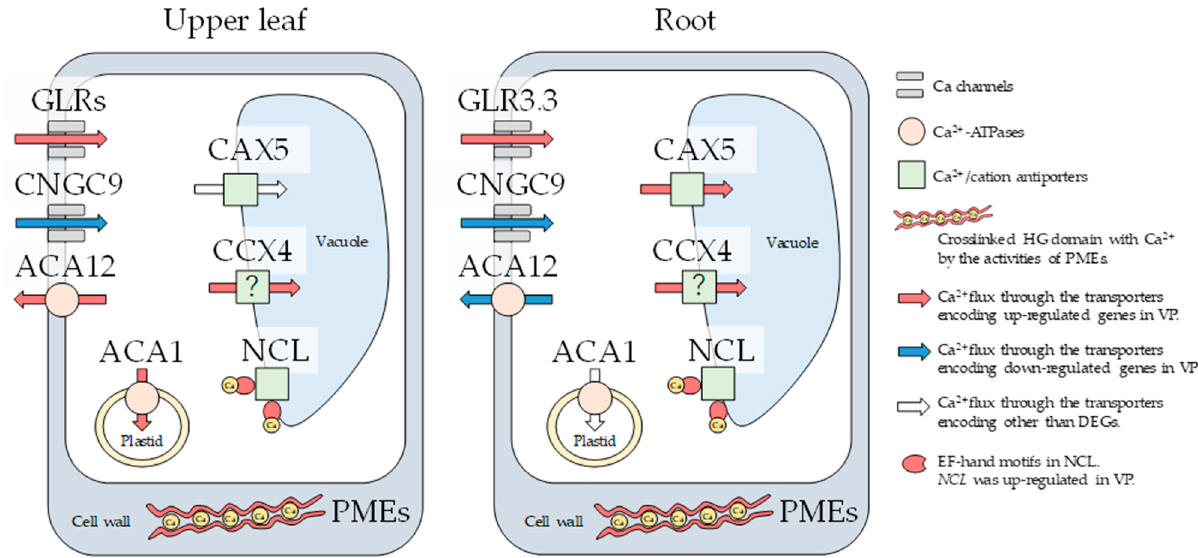
Figure 2. Hypothetical diagram of cellular Ca dynamics in upper leaves and roots of tipburn high damaged cultivar (VP). Direction of arrows indicates Ca flux through the transporters.